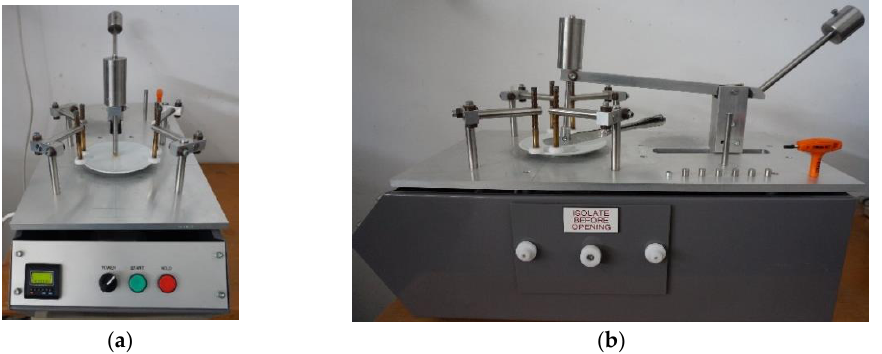
Figure 11. Metal marking machine ( a ) front view with steel ball test; ( b ) side view with a knife fixed to the moving arm. Manufacturer: Anderen Limited, Stoke-on-trent, UK.